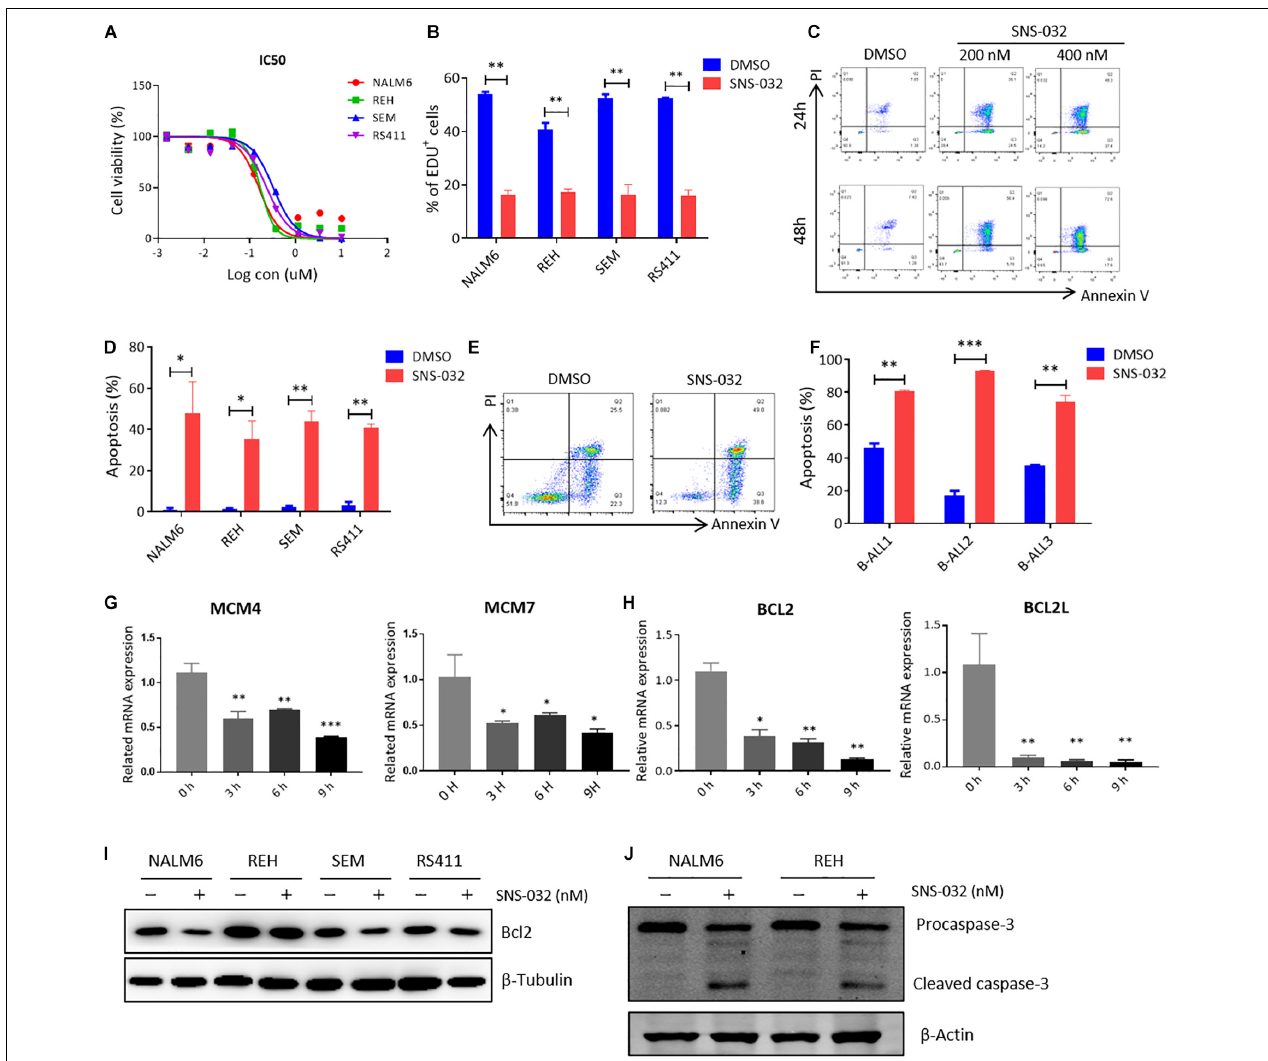
FIGURE 1 | SNS-032 treatment inhibits proliferation and induces apoptosis in B-ALL cells. (A) Drug sensitivity assay of NALM6, REH, SEM, and RS4;11 cell lines. B-ALL cells were treated with a gradient concentration of SNS-032 for 72 h. (B) EdU-labeled cell cycle of B-ALL cell lines was analyzed by flow cytometry. (C) Annexin V and PI labeled cell apoptosis of REH cells was analyzed by flow cytometry. (D) Statistical analysis of the cell apoptosis rates of B-ALL cell lines. (E) Annexin V- and PI-labeled cell apoptosis of B-ALL patient sample was analyzed by flow cytometry. (F) Statistical analysis of cell apoptosis rates in three patients. (G,H) The DNA replication and anti-apoptosis genes of B-ALL cells were measured by qRT-PCR. (I,J) The anti-apoptosis and apoptosis proteins of B-ALL cells were detected by Western blot analysis. B-ALL cells were treated with SNS-032 (200 nM for NALM6, 200 nM for REH, 350 nM for SEM, 250 nM for RS411, and 200 nM for primary B-ALL cells) for 24 h. Values were shown as mean ± SEM. ∗ p < 0.05, ∗∗ p < 0.01, and ∗∗∗ p <